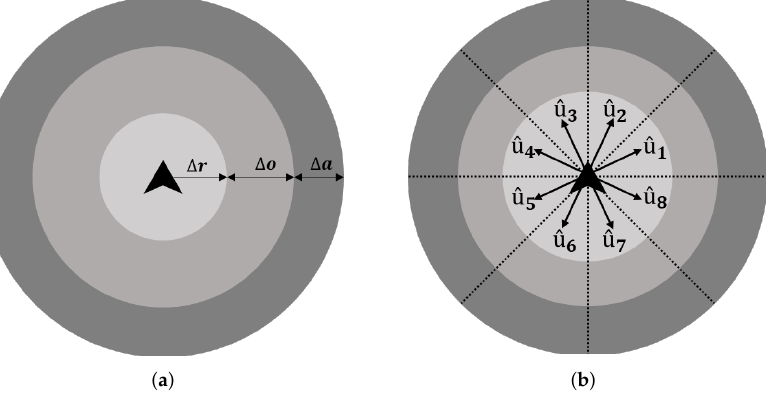
Figure 1. Sensing zones and view sectors of agents: ( a ) The three agent perception zones; and ( b ) the eight view